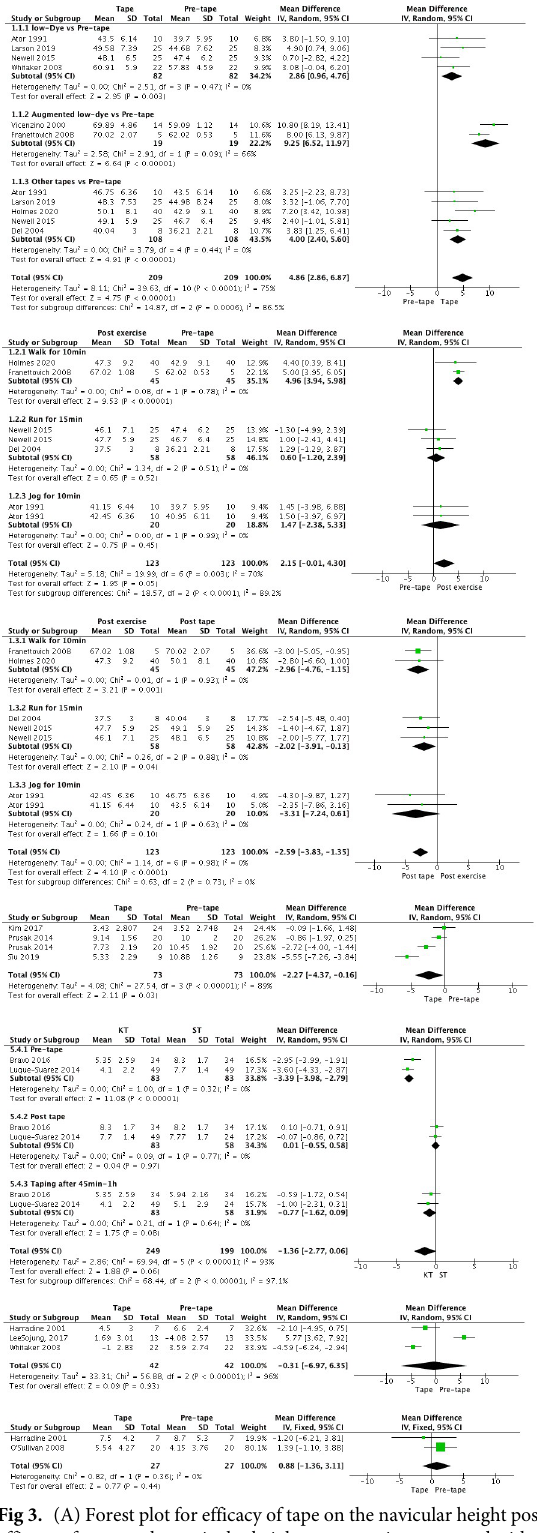
Fig 3. (A) Forest plot for efficacy of tape on the navicular height post-tape compared with pre-tape; (B) Forest plot for efficacy of tape on the navicular height post exercise compared with post-tape; (C) Forest plot for efficacy of tape on the navicular height post-tape compared with pre-tape; (D) Forest plot for acute and post exercise efficacy of kinesio